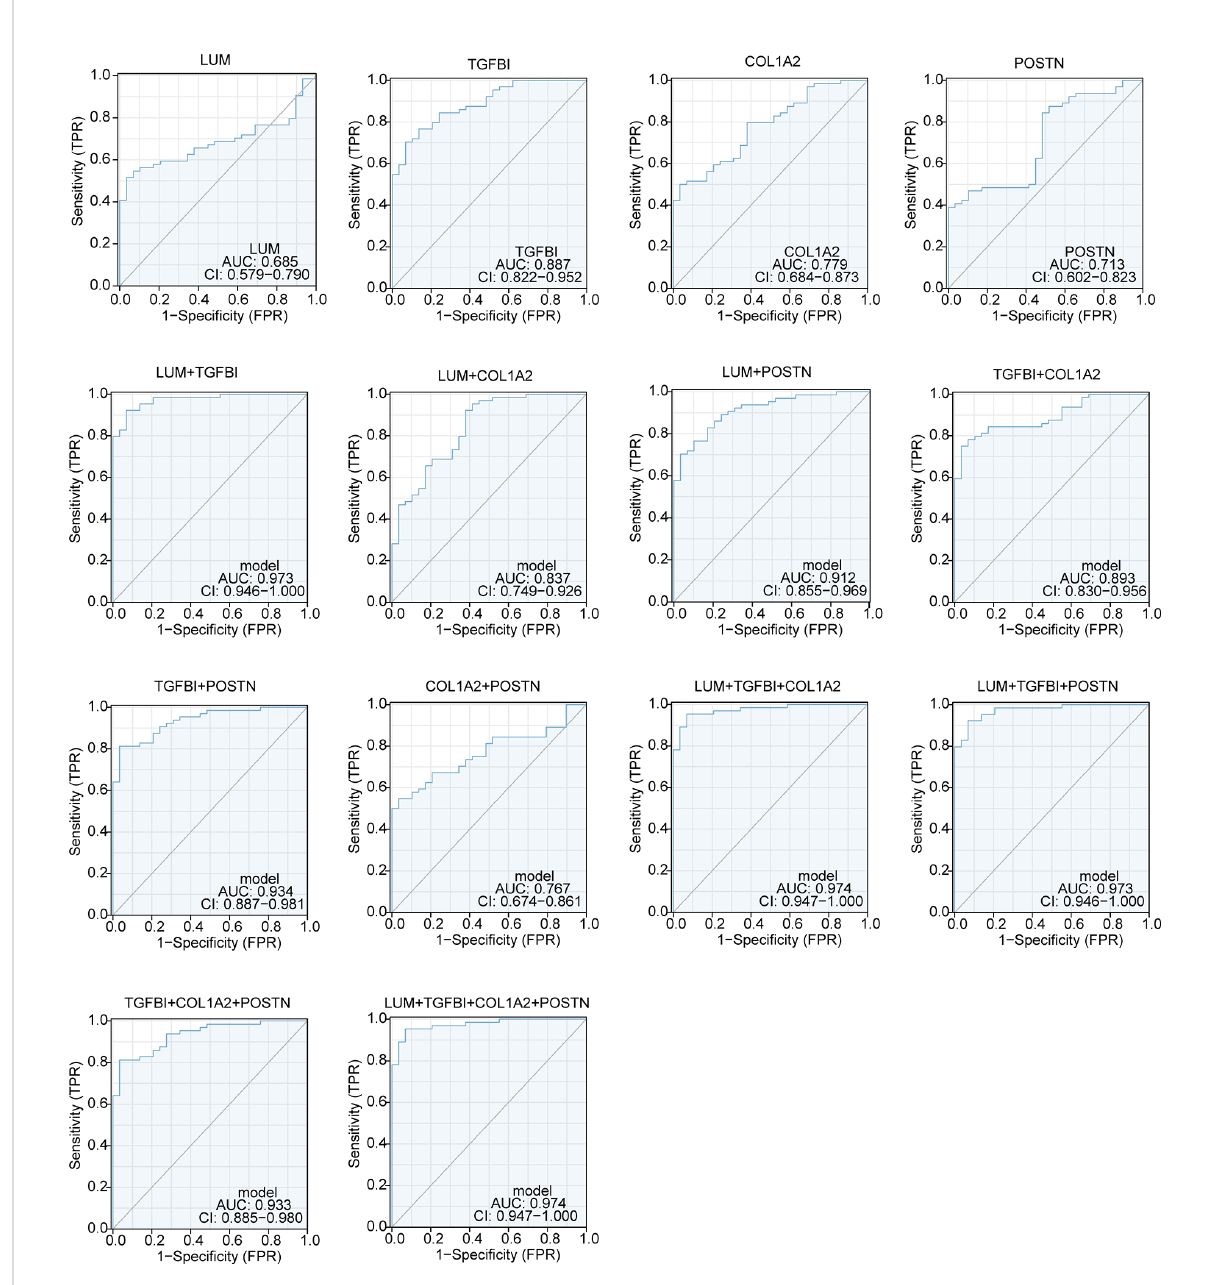
FIGURE 9 The diagnostic value of LUM, TGFBI, COL1A2, and POSTN in LN